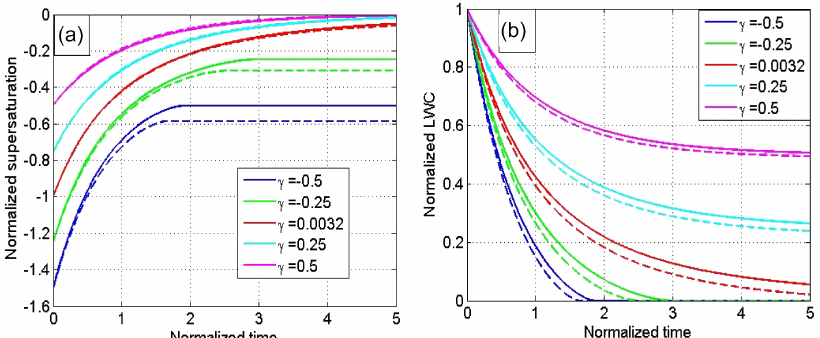
Figure 4. Universal dependencies e S( e t) (a) and e q( e t) (b) , calculated at different values of parameter γ using Eqs. (17)–(18) (solid lines) and using a parcel model (dashed lines).